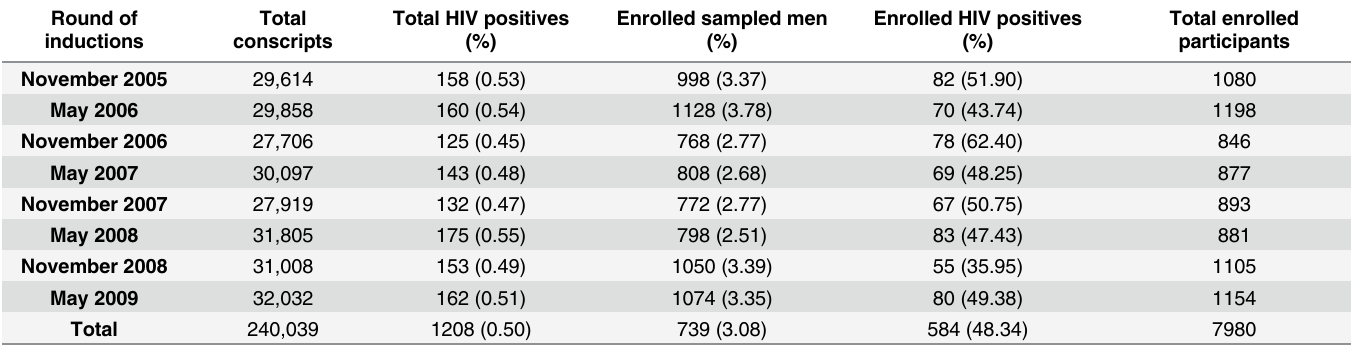
Table 1. Number of participants.